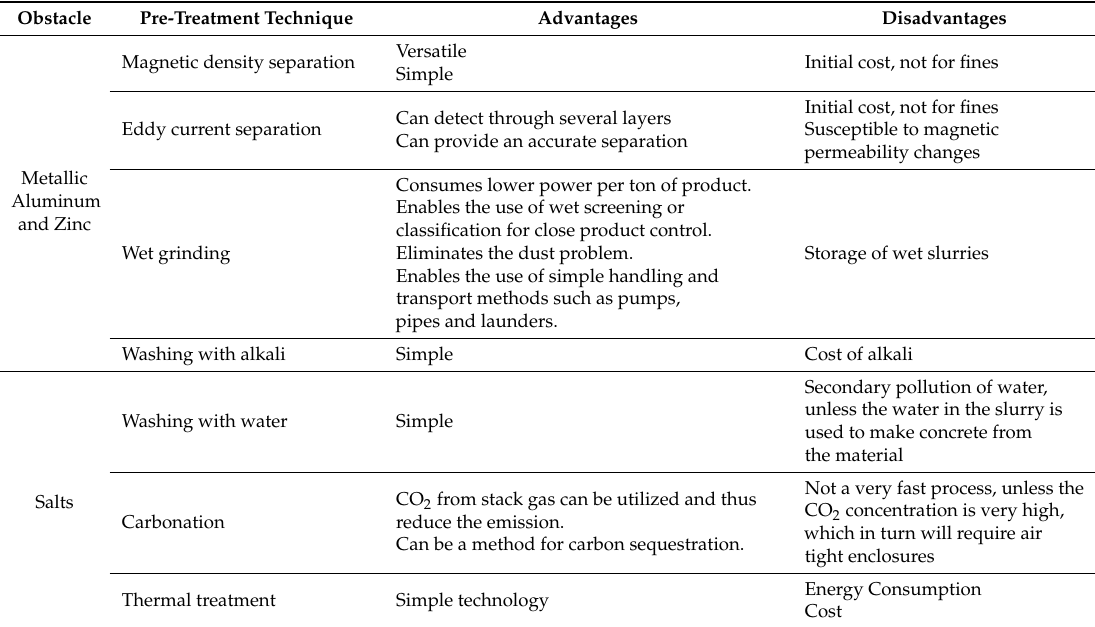
Table 5. Summary